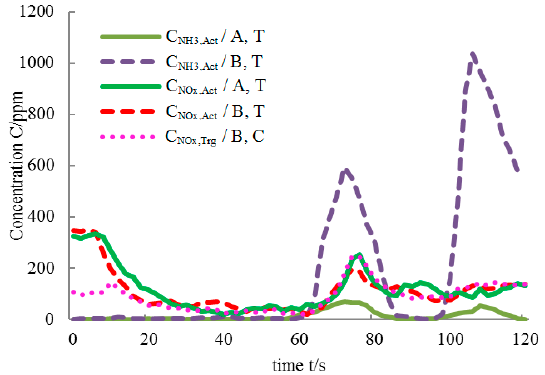
Figure 8. The NO x and NH 3 emissions before and after the correction.